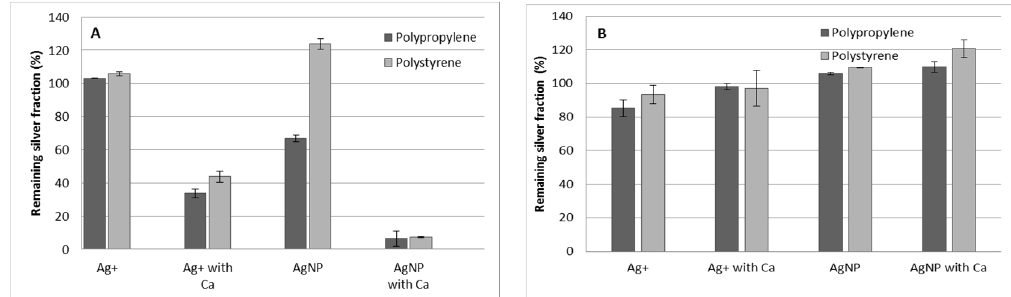
Figure 1. Remaining silver fraction using different tube materials without the presence of resin. ( A ) In the absence of humic acids. ( B ) In the presence of humic acids. Error bars represent standard deviation n = 2.